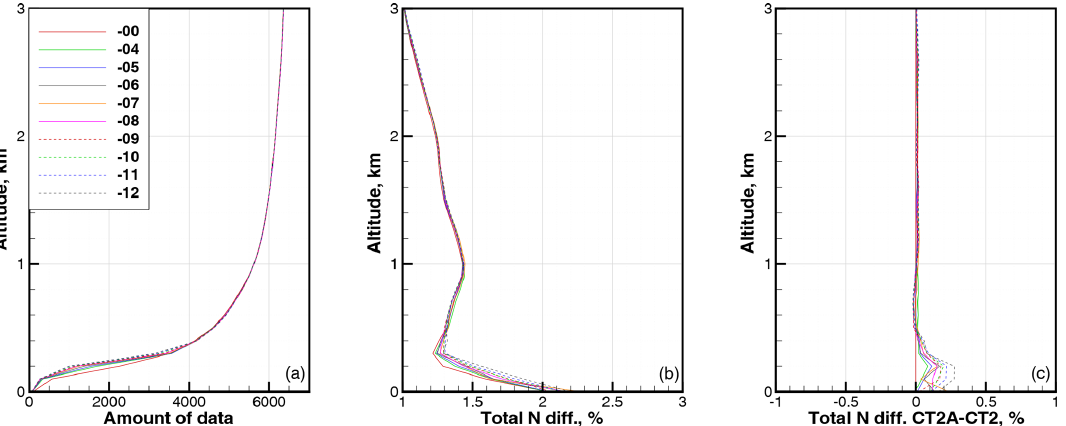
Figure 8. Statistics for latitude band 50–60 ◦ . (a) Amount of data. (b) RMS relative difference in refractivity COSMIC–ECMWF (cid:49)N CE . (c) RMS relative difference in refractivity CT2A–CT2. All are functions of the parameter β .